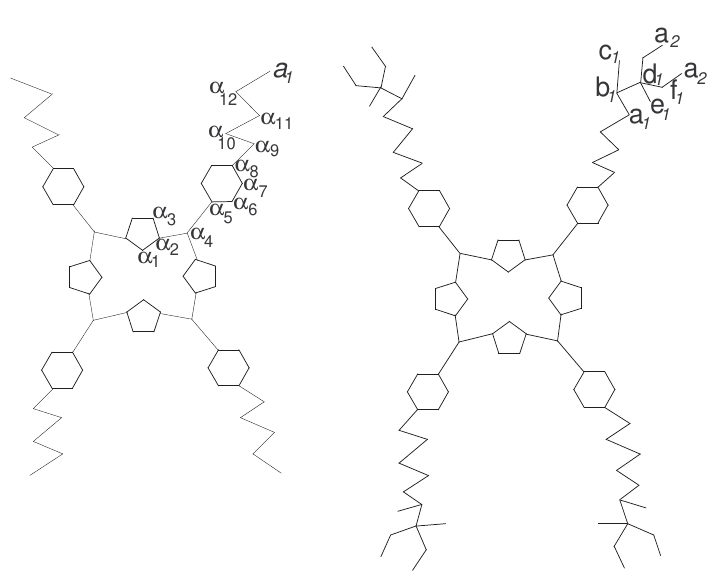
Figure 2. Core of the dendrimer D ( n ) ; first generation of the dendrimer D ( n ) .